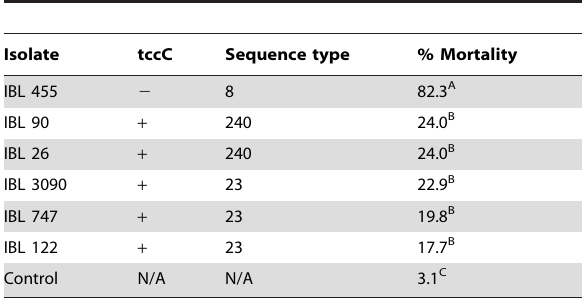
Table 1. Mortality of gypsy moth larvae fed Bt isolates with tca genes compared with a DiPel derived strain (IBL 455).